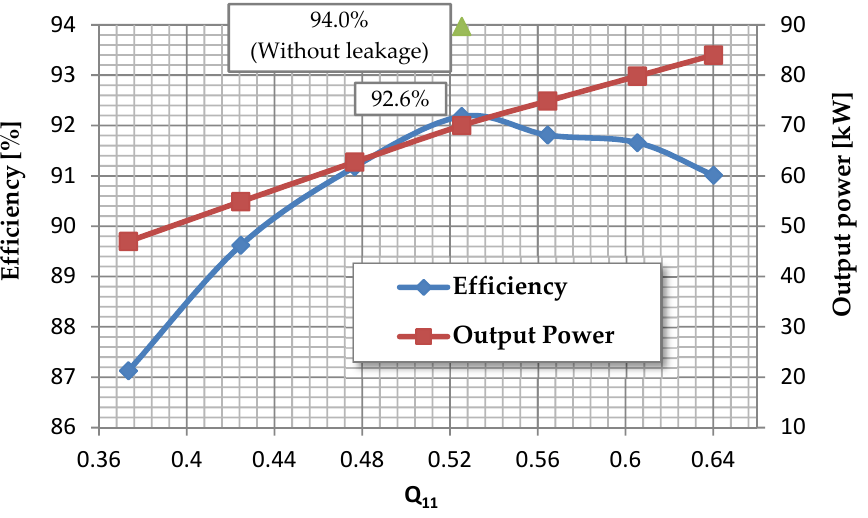
Figure 15. Performance of the Francis turbine by the flow rate.